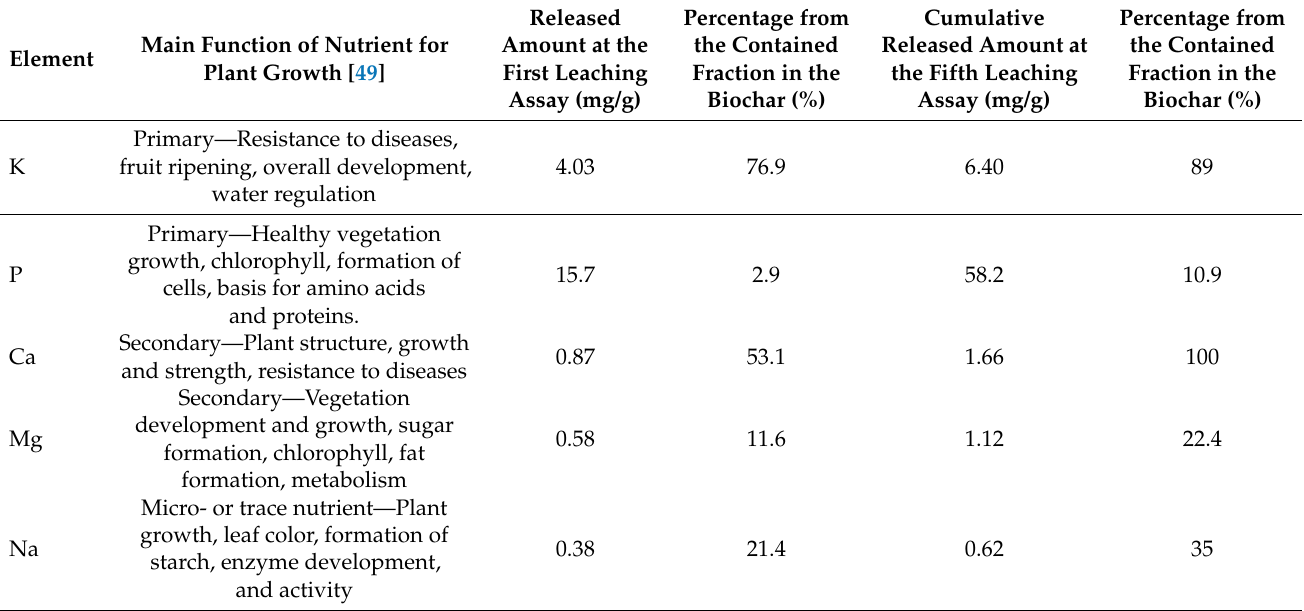
Table 7. Nutrient release efficiency after 1 and 5 leaching cycles from FS treated